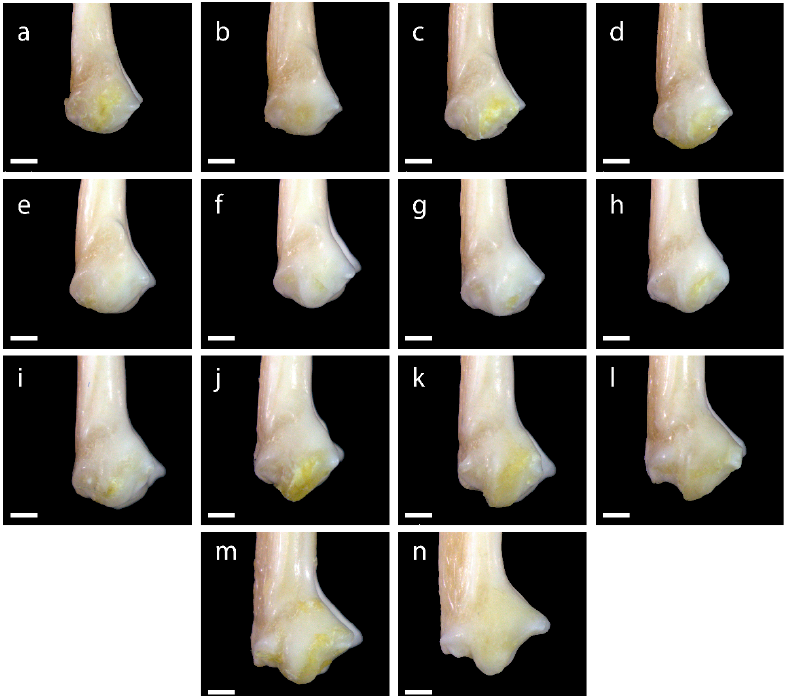
Figure A13. Microscopic images of the lateral left view of the pinnules of P. bichir PO3. The images ( a – n ) correspond to the 1st, 2nd, 3rd, 4th, 5th, 6th, 7th, 8th, 9th, 10th, 11th, 12th, 13th, and 14th pinnules, respectively. Scale = 1 mm.